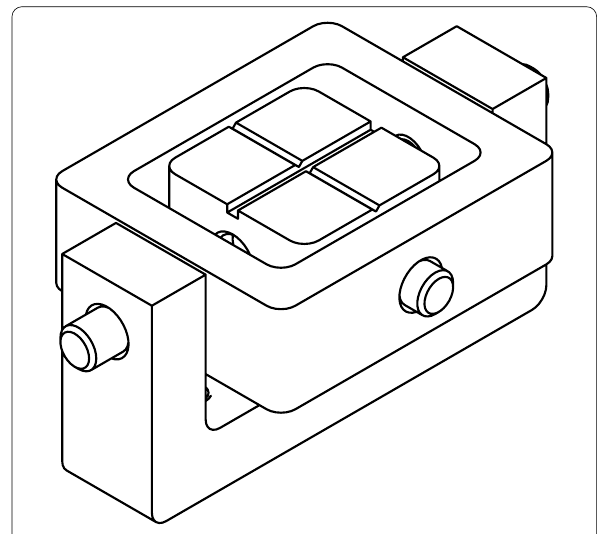
Figure 4 Cardanic bearing for out‑of‑plane tensile tests